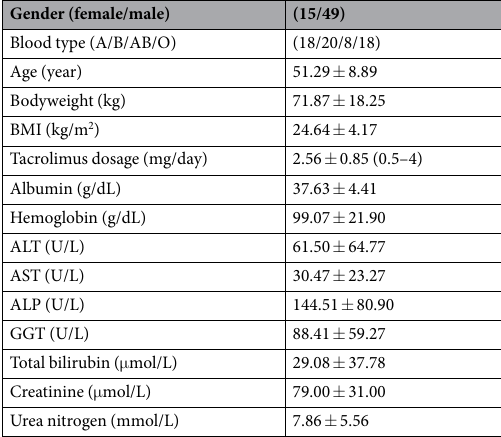
Table 1. Demographic characteristics of recipients at the third week after liver transplantation. Clinical parameters in blood are shown as Mean ±